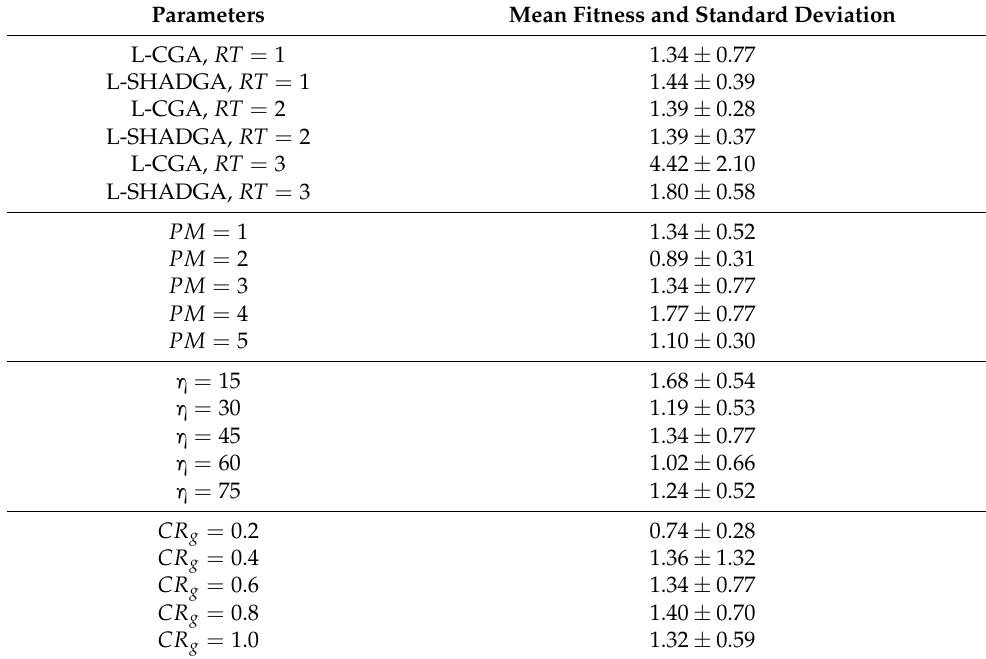
Table 4. Experimental results for 5-mode micrsostrip resonator.